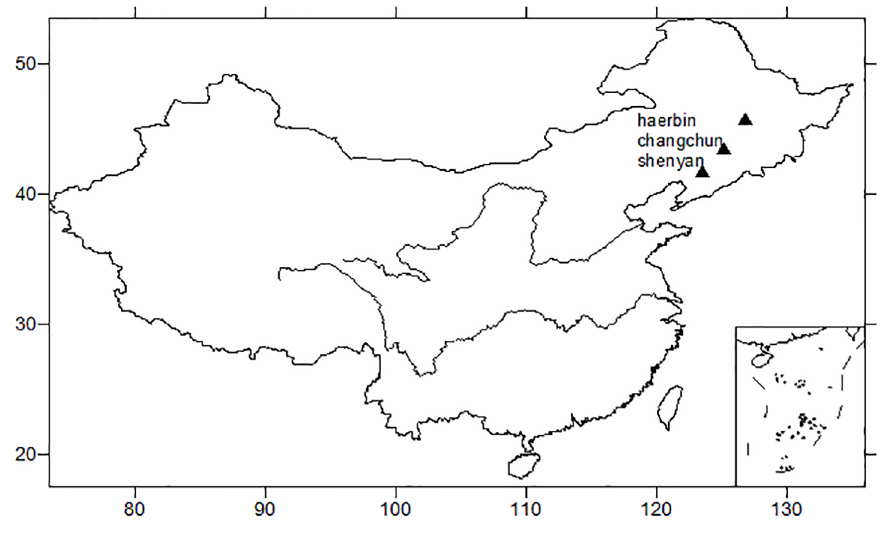
Fig 2. Annual mean temperature(units:˚C) time series from 1909–2014 at (a) Harbin; (b) Changchun; (c) Shenyang.